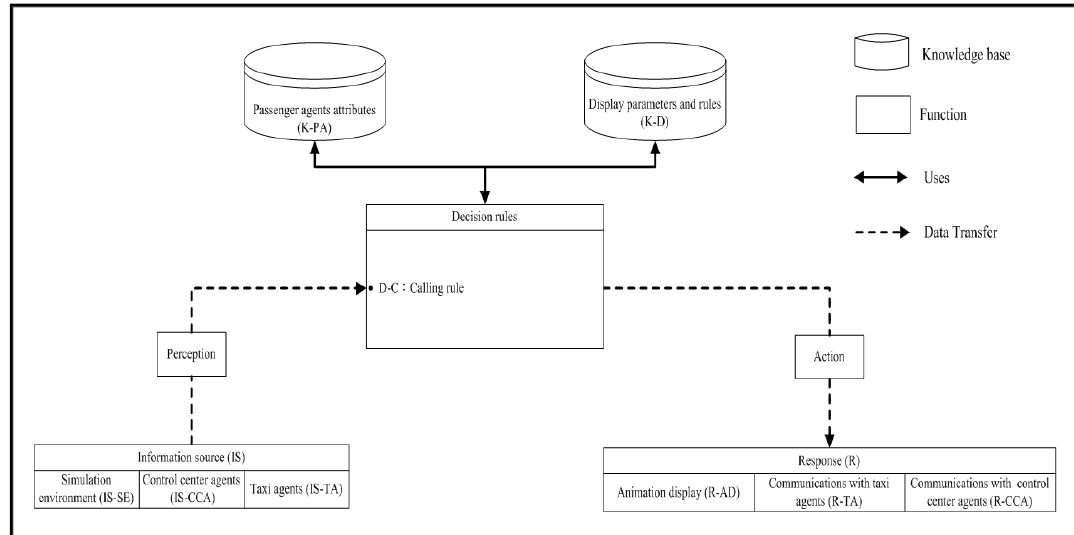
Figure 4. “The framework of Passenger